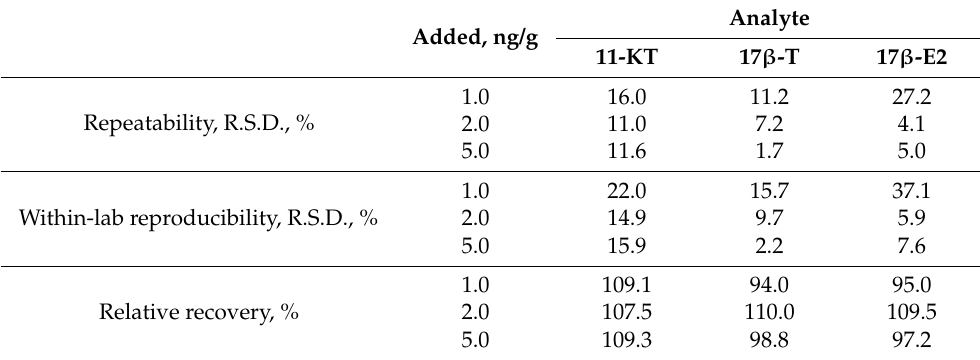
Table 4. Repeatability, within-laboratory reproducibility and relative recovery in evaluated male gonad samples.